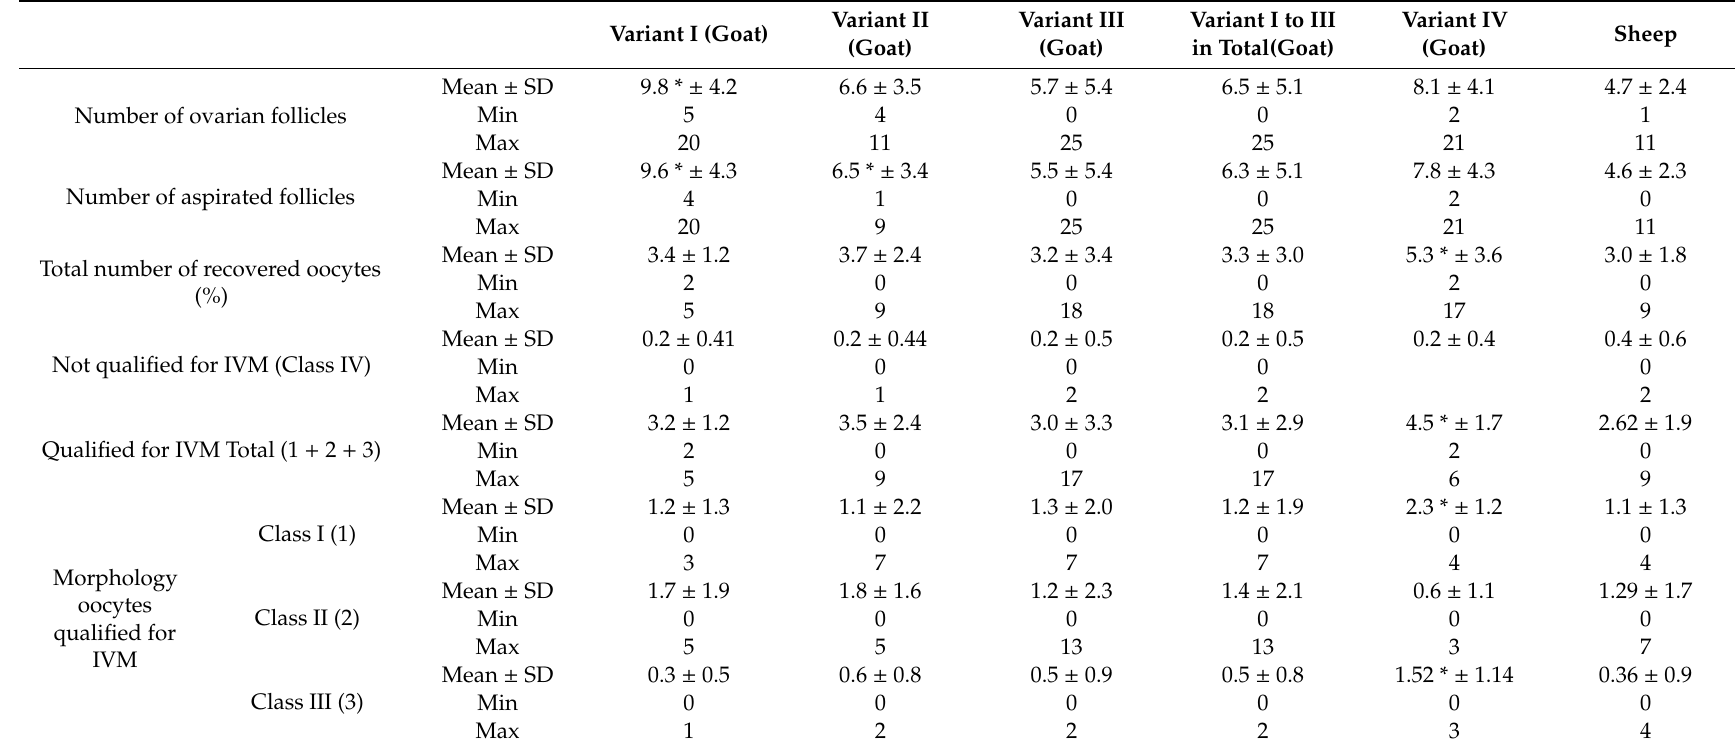
Table 2. E ff ectiveness of the laparoscopic ovum pick-up (L-OPU) method among goats and ewes expressed per